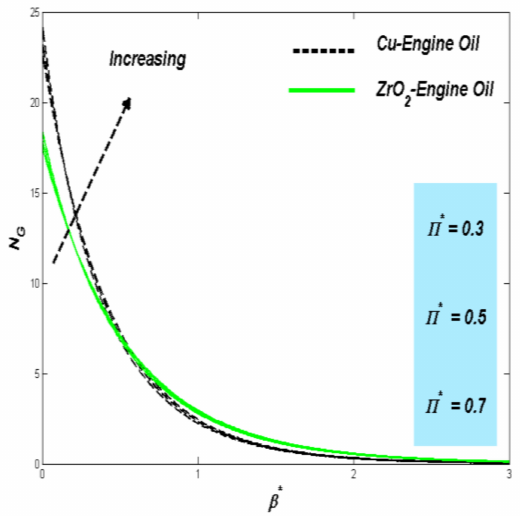
Figure 10. Entropy profile change with Π ∗